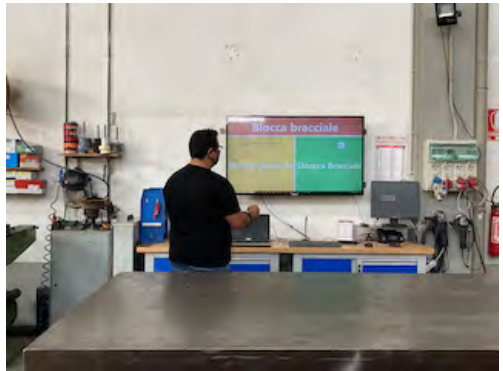
Figure 1. User interacting with a large display via a touchless gestural interface [23,24].